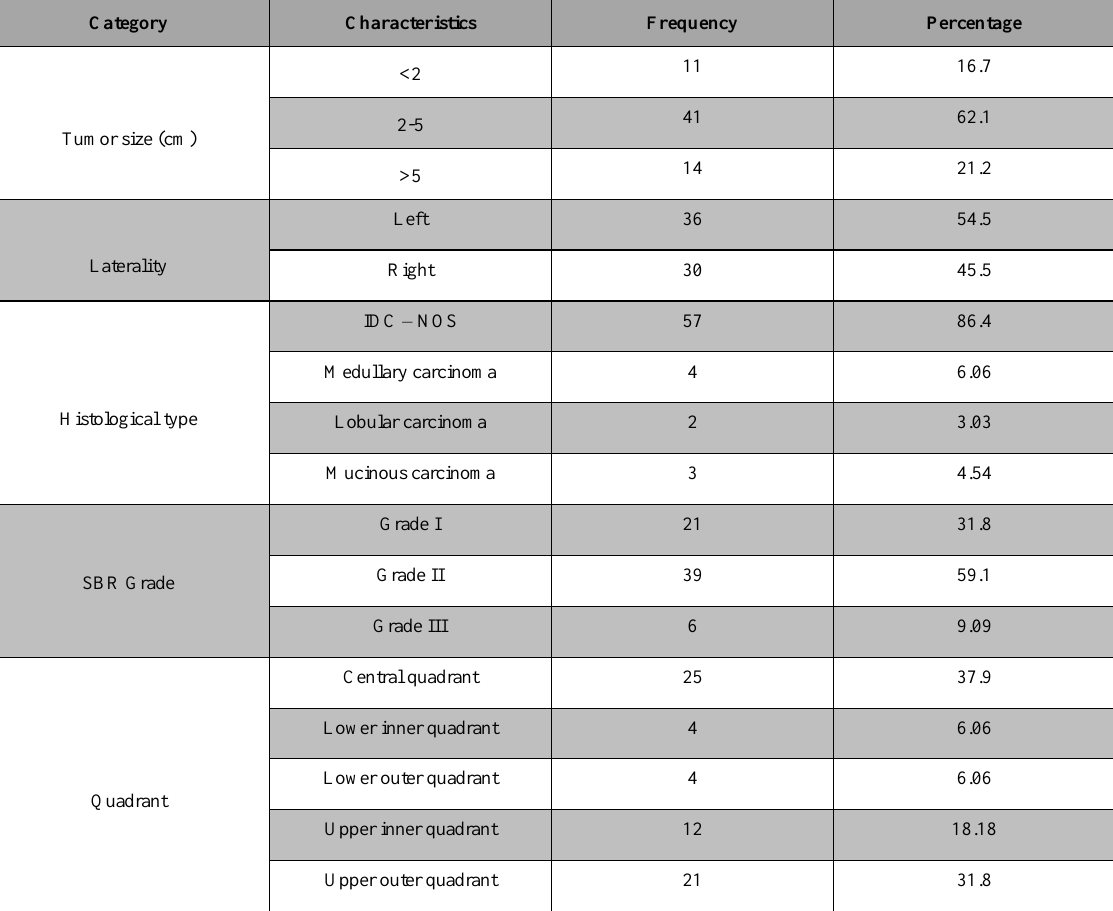
Table 1. Tumor distribution according to size, laterality, histological type, SBR Grade, and quadrant.